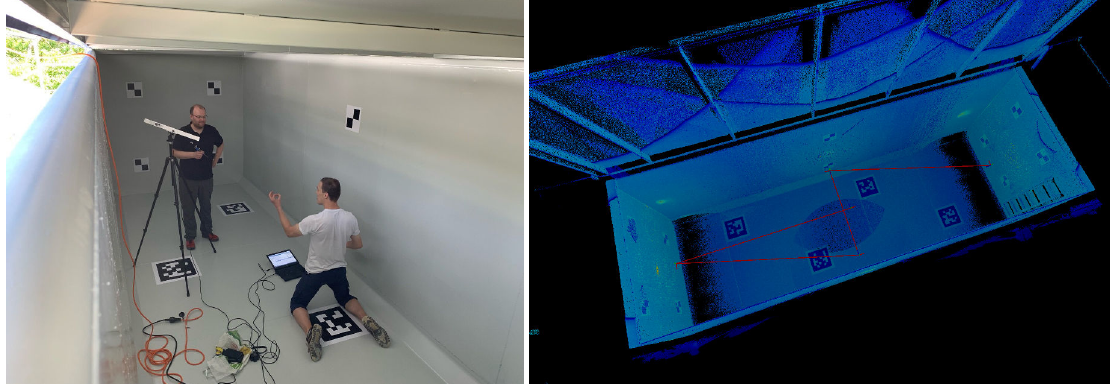
Figure 2. Left: Look inside the container without water. An OptiTrack V120:Trio system is used to determine the positions of the placed makers. Right: A point cloud of the container captured with a Riegl VZ-400 before the container was filled with water.